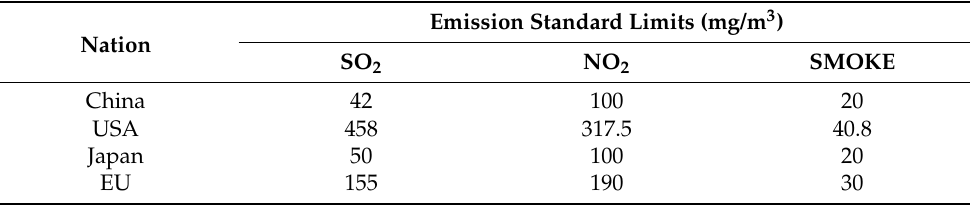
Table 2. Emission standard limits of major air pollutants for thermal power plants in major countries in the world [27].